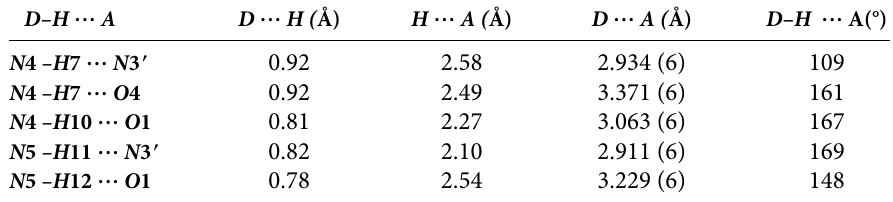
Symmetry codes: –1/2 + x , –5/2 – y , z ; –1/2 + x , –5/2 – y , z ; – x , –3 – y , 1/2 + z ; 1/2 + x , –5/2 – y , z ; –1/2 – x , –1/2 + y , 1/2 + z